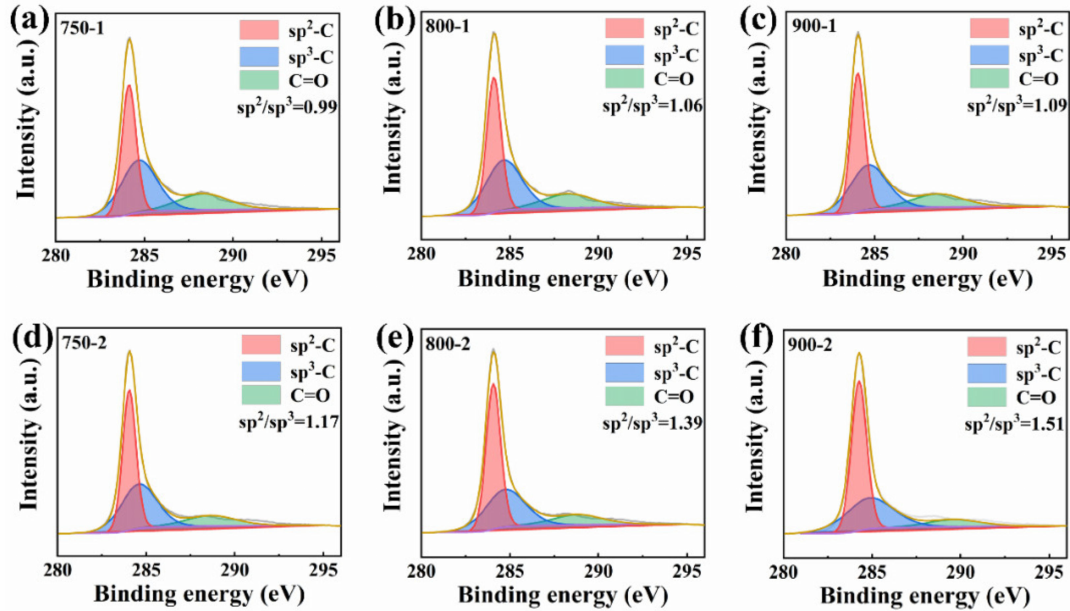
Figure 5. ( a ) XPS spectrum of C1s for 750-1; ( b ) XPS spectrum of C1s for 800-1; ( c ) C1s spectrum for